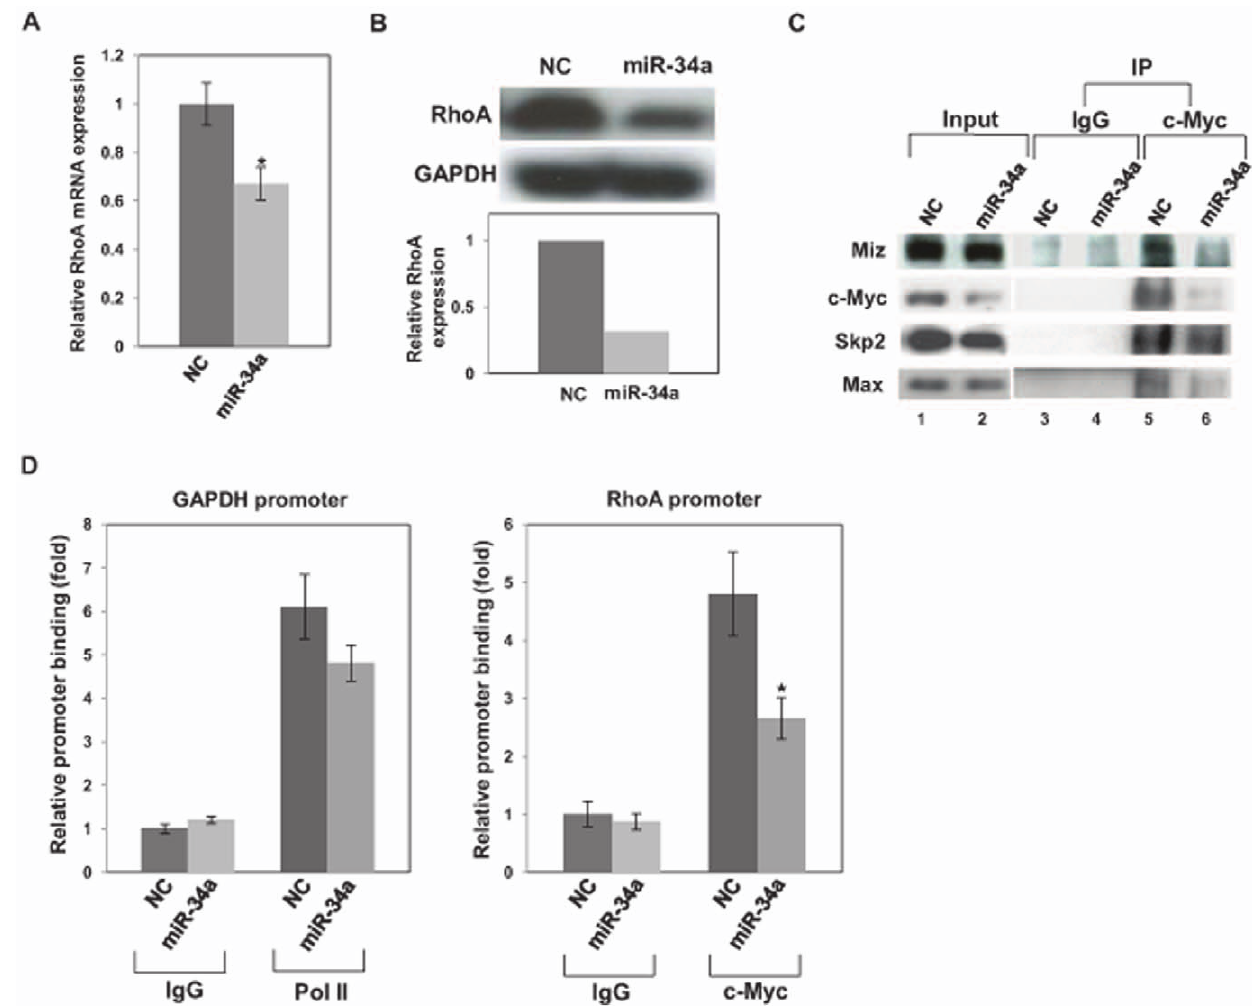
Figure 4. miR-34a suppresses the c-Myc transcriptional complex of RhoA. PC-3 cells were transiently transfected with pre-miR negative control (NC) or pre-miR-34a for 72 h. (A) RhoA mRNA level was analyzed by real-time PCR. (B) RhoA protein expression was analyzed by Western blot. (C) c-Myc pulls down endogenous Miz1, Skp2 and Max in PC-3 cells. PC-3 cells were transiently transfected with pre-miR negative control (NC) or pre– miR-34a for 72 h and total cell lysates were immunoprecipitated with c-Myc antibody or IgG (control), followed by Western blot analysis. (D) miR-34a decreases the recruitment of c-Myc to the RhoA promoter. PC-3 cells were transiently transfected with pre-miR negative control (NC) or pre–miR-34a for 72 h and ChIP assays were performed. *, P , 0.05 compared with control. doi:10.1371/journal.pone.0029722.g004 (Fig. 1). PC-3 cells were transfected with a c-Met expression plasmid together with pre-miR-34a. c-Met expression levels were examined by Western blot which indicated that c-Met expression was increased in the c-Met transfected cells (Fig. 7A). c-Met promoted invasion in control experiments. c-Met reversed miR- 34-induced suppression of invasion, indicating that miR-34a inhibits invasion, at least partially, by targeting c-Met (Figs. 7B and C).